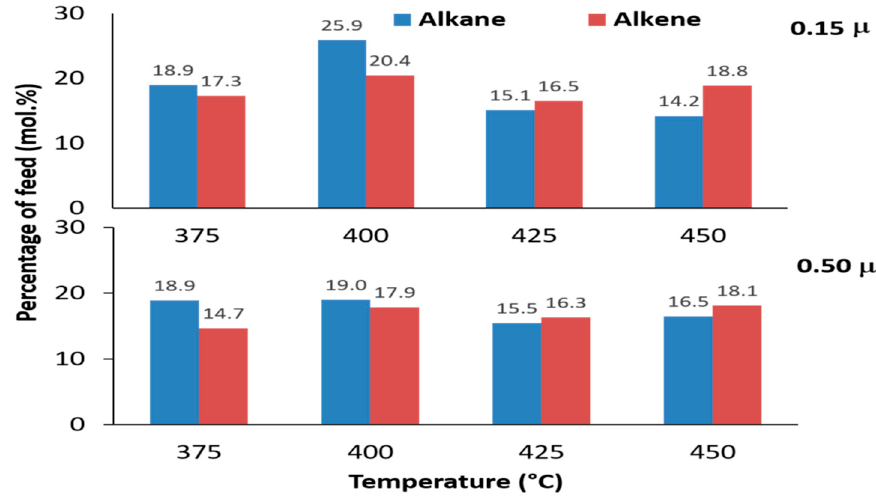
Figure 4. The n-alkane and 1-alkene composition liquid products from pyrolysis of mixed-metal basic soap at various reaction temperatures with two different Ca metal ratios ( μ ).